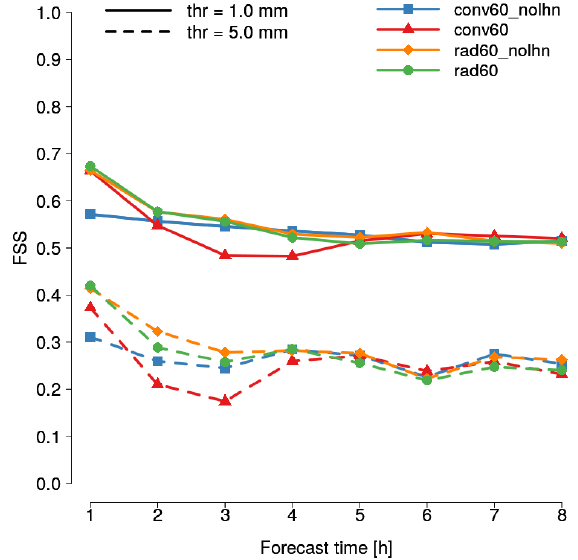
Figure 6. Fractions skill score as a function of lead time for conv60_nolhn (blue), conv60 (red), rad60_nolhn (orange) and rad60 (green). Verification is performed considering hourly precip- itation and 1mm (solid lines) and 5mm (dashed lines)